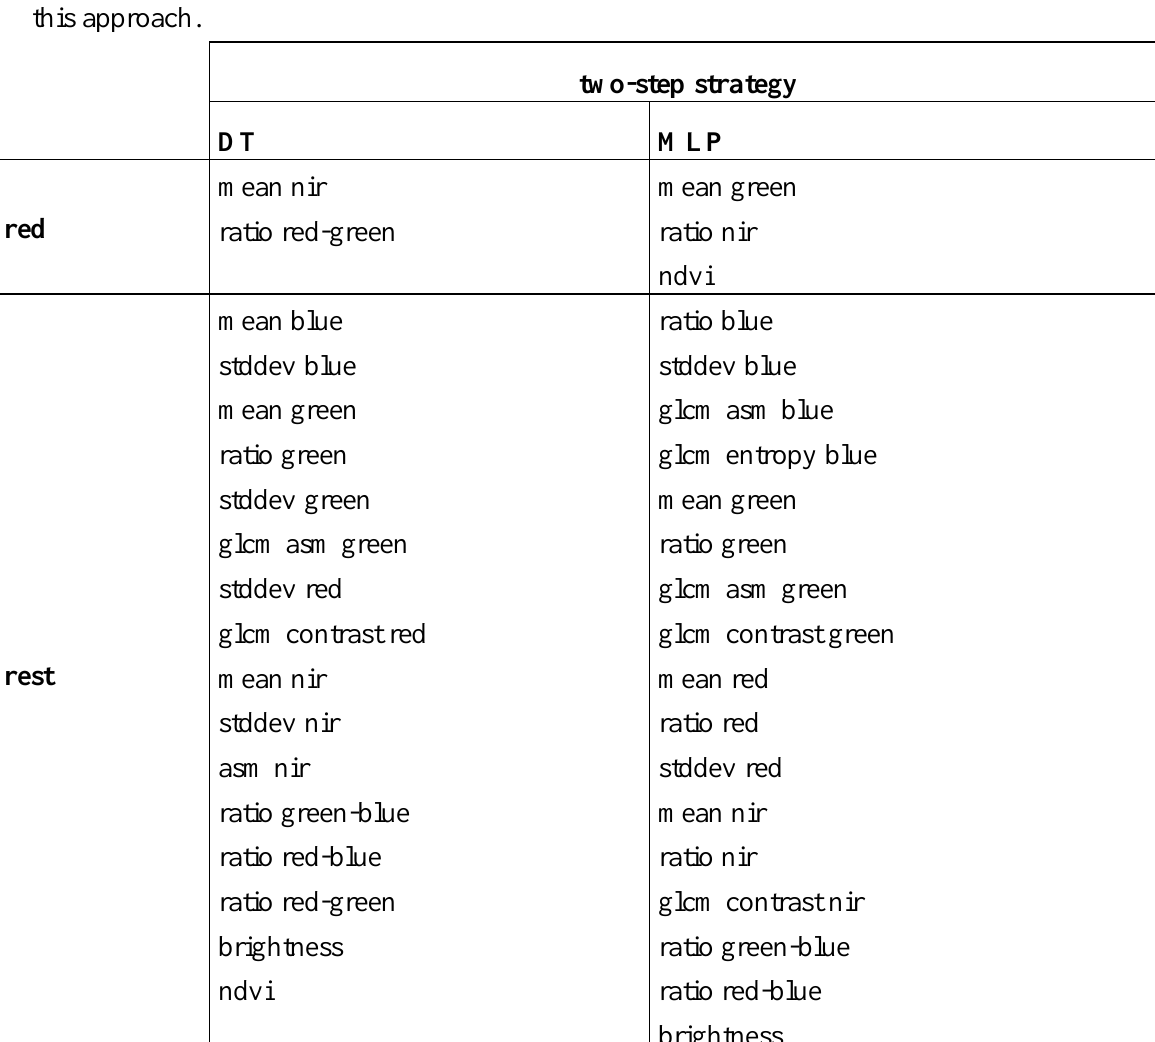
Table 3. Selected input variables for each phase in the two-step and the full hierarchic classification strategy for DT and MLP classification. In the two-step strategy, ‘red’ stands for the red surfaces class and ‘rest’ for the other classes, which are classified in one step in this